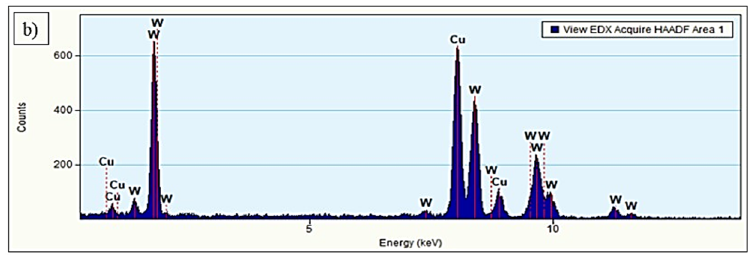
Figure 7. Elemental distribution maps of spraying elements in the analyzed area of the C3 coating obtained during thermal spraying :( a )—central part of the layer, ( b )—map of the carbon, ( c )—map of the chromium, ( d )—map of the tungsten, ( e )—map of the nickel.